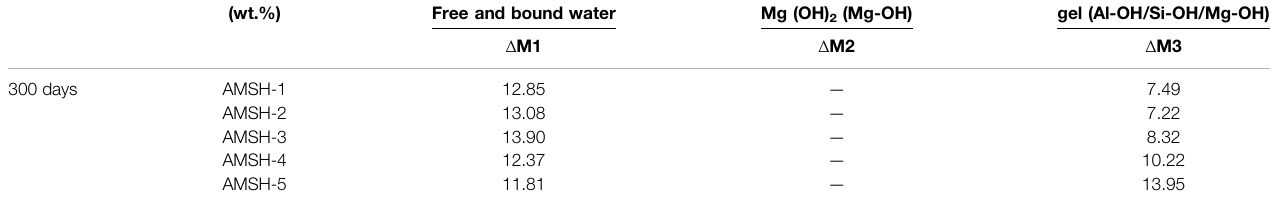
TABLE 3 | Mass percents of various components in AMSH samples after curing for 300 days. (wt.%)